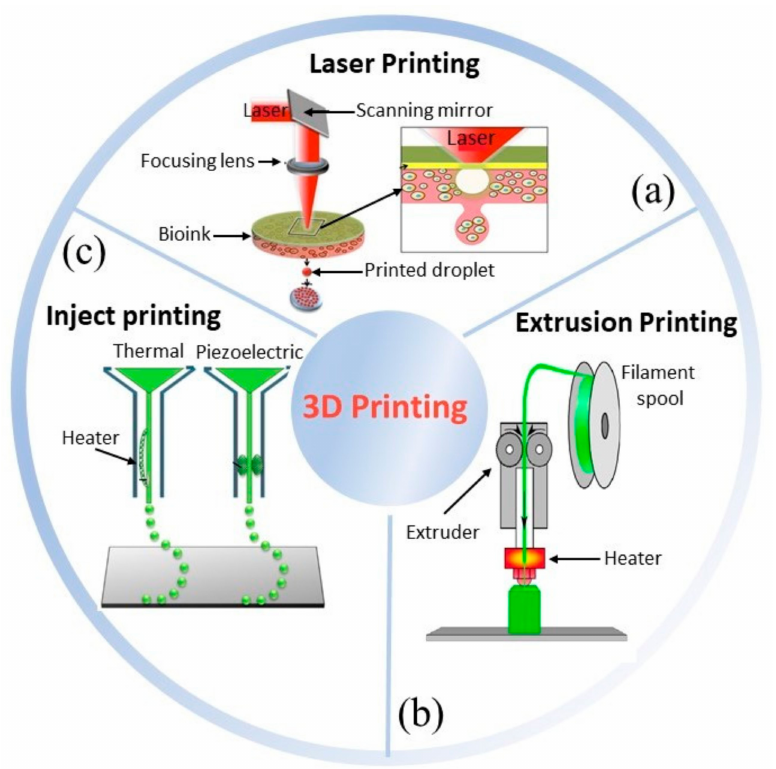
Figure 1. Three main bioprinting technologies: ( a ) laser [18], ( b ) extrusion [19], ( c ) inject printing [20]. Parts of the figure are reprinted from [18–20]—open access under Creative Commons CC BY 4.0